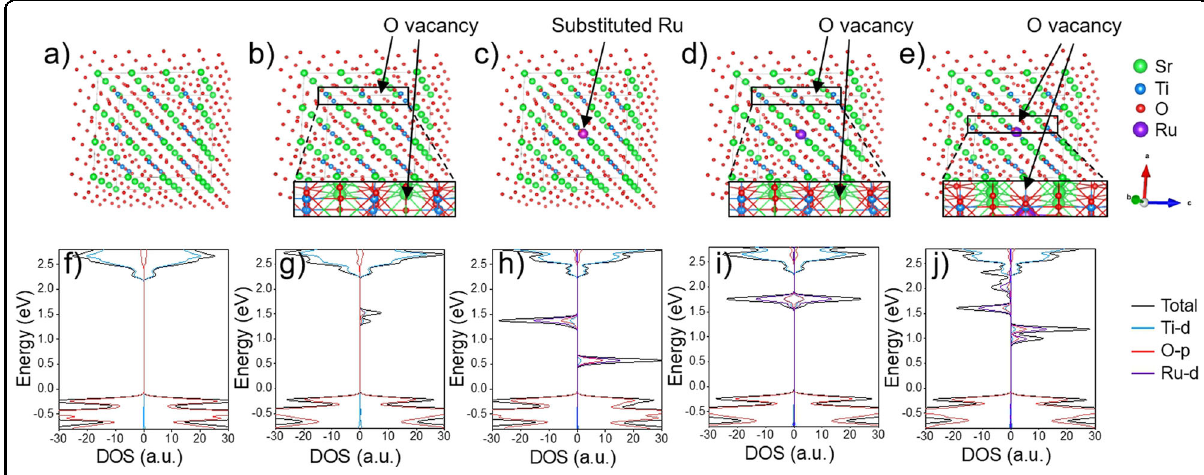
Fig. 4 Band structure predictions for SrTiO 3 according to various arrangements of the substituted Ru atoms and oxygen vacancies. Different structures in a 3 × 3 × 3 supercell with a any substituted Ru and oxygen vacancy, b one oxygen vacancy, c one substituted Ru, d one substituted Ru and one oxygen vacancy separated from each other, and e one substituted Ru adjacent to one oxygen vacancy. f – j Density of states corresponding to the aforementioned arrangements of substituted Ru and oxygen vacancies.